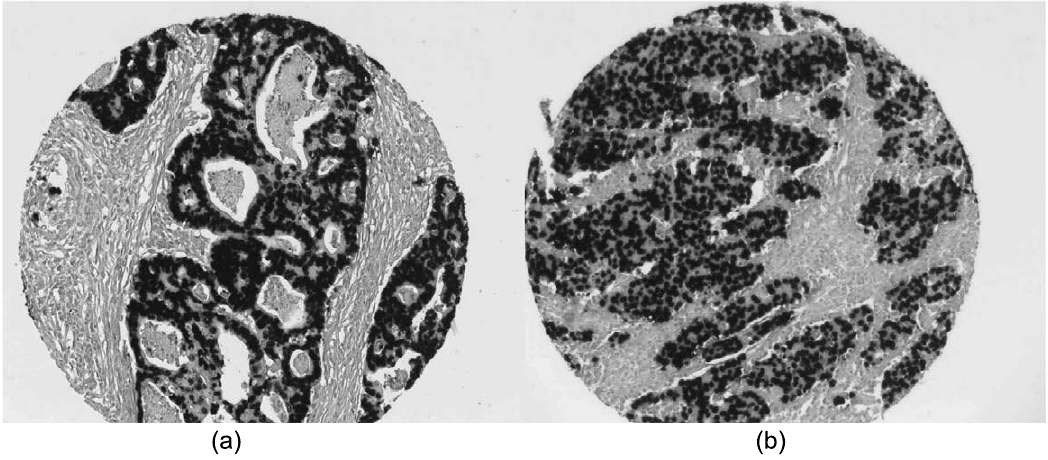
Fig. 1. EBV-positive gastric cancer in RNA in situ hybridization (RISH). (a) Moderately differentiated (G2); (b) poorly differentiated (G3). than EBV-negative adenocarcinomas ( n = 74):